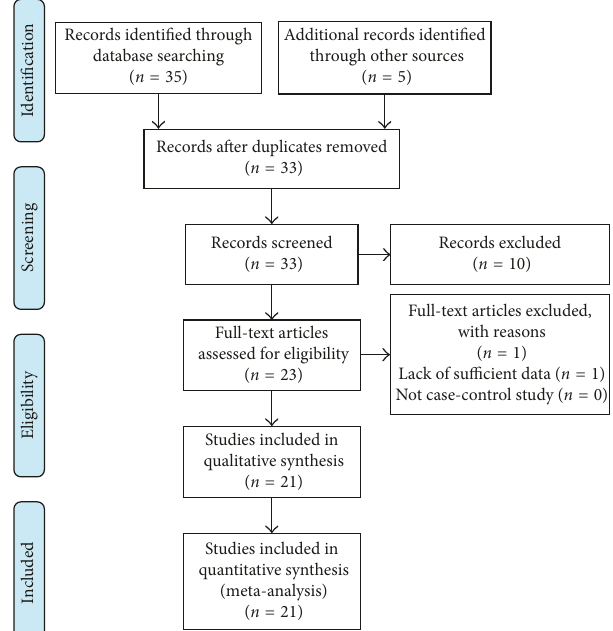
Figure 4: Prisma